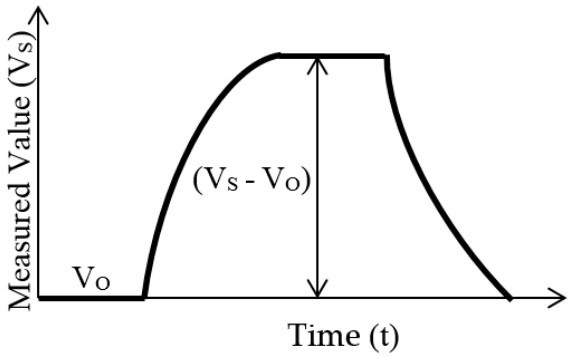
Figure 6. Typical sensor response.